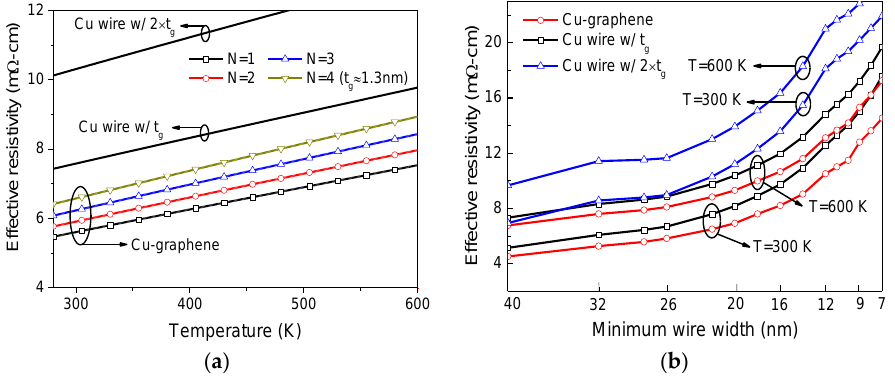
Figure 17. Effective resistivity of Cu and Cu-graphene interconnects versus (a) temperature and (b) technology node [110].